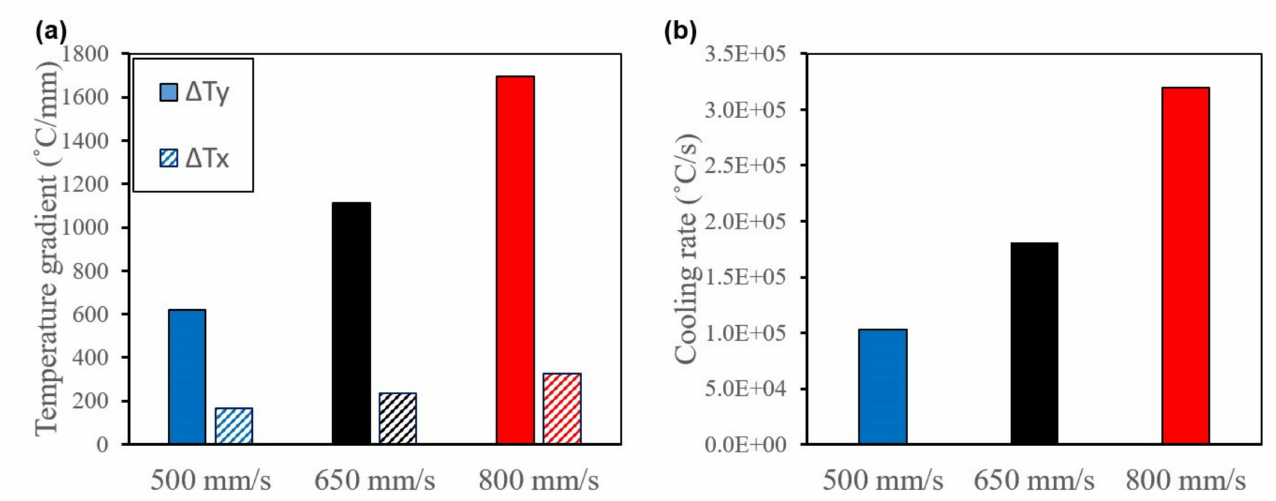
Figure 25. Effect of scan speed on ( a ) temperature gradient and ( b ) CR at 220 W and 0.12 mm.